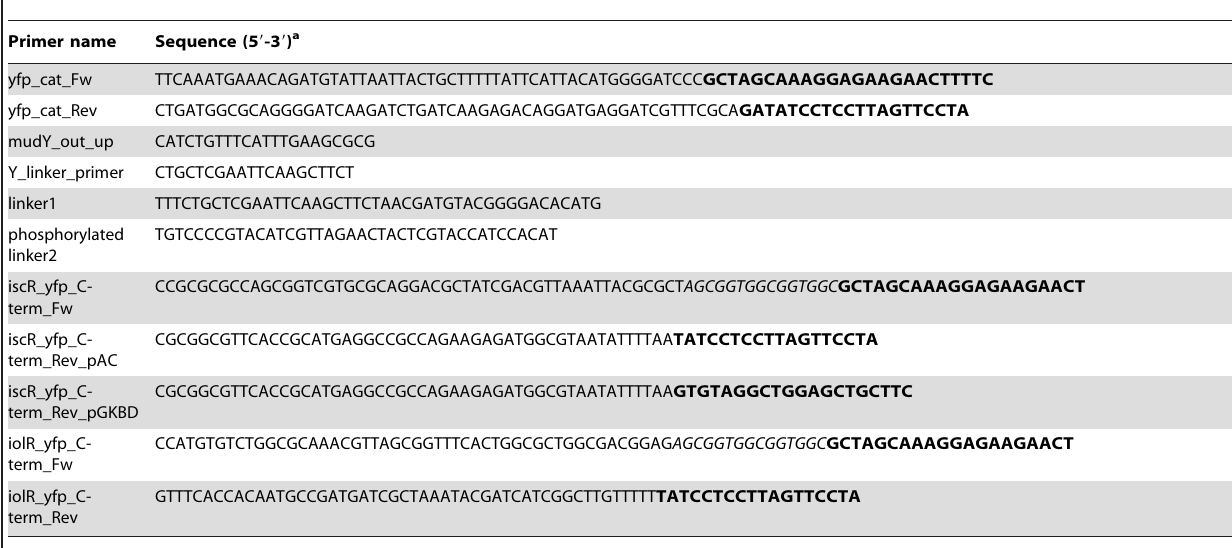
Table 2. Primers used in this